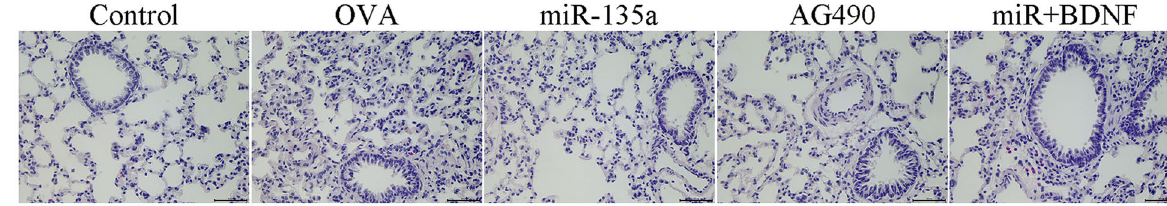
Figure 6. Effect of regulation of JAK/STAT signaling pathway on lung histopathology by immunohistochemistry staining in mice ( (cid:2) 400, scale bar: 50 m m).